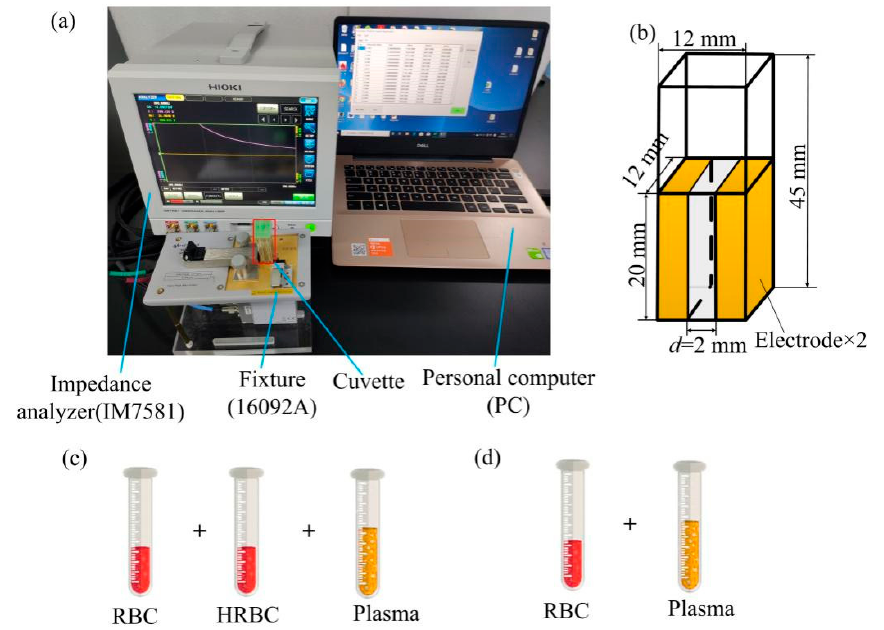
Figure 1. ( a ) Experimental setup; ( b ) structural dimension of the cuvette; ( c ) sample preparation of blood with different burn injury degrees (plasma, RBCs and HRBCs); ( d ) sample preparation of blood with different concentrations of RBCs.